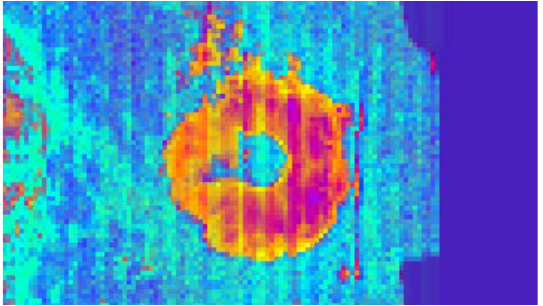
Figure 6. - The visualization of a lunar crater generated with a decorrelated stretching of a color composite using CE-1